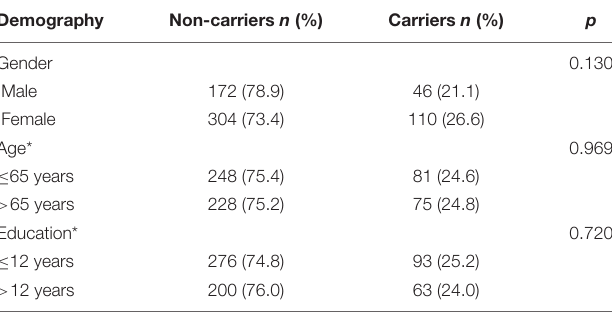
TABLE 2 | The distribution of APOE ε 4 carriers and non-carriers in different